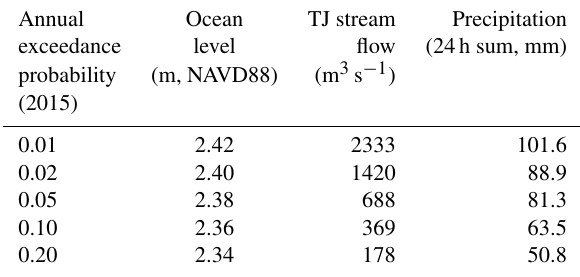
Table A2. Most likely estimates of exceedance probabilities asso- ciated with extreme ocean levels, TJ streamflow, and precipitation. These values were used as boundary conditions for the hydrologic and hydraulic